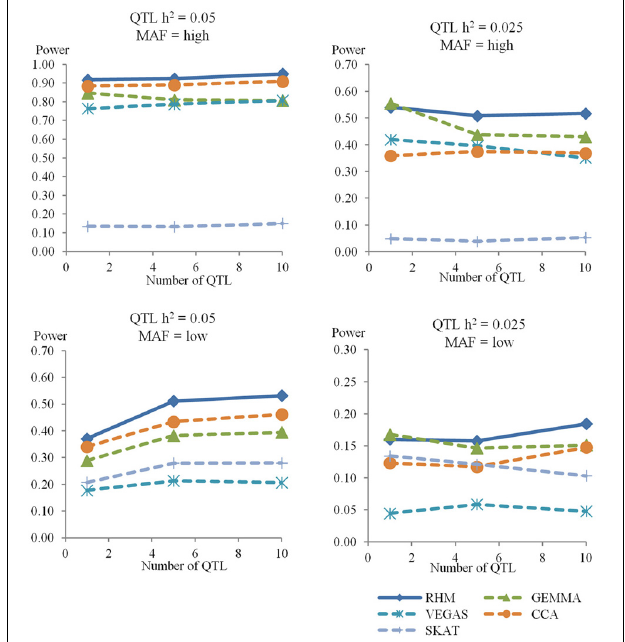
FIGURE 3 | The power to achieve 5% genome-wide significance in the gene region. The powers in the simulation study for genome heritability 0.4 were calculated by RHM with window size 10 (RHM), single-SNP GWAS (GEMMA), and three gene-based association approaches (VEGAS, CCA, and SKAT) in the different situations. The number of QTL is on the x-axis, and the power to detect QTL is on the y-axis. Each graph shows the different situations for genome heritability 0.4 (QTL heritability is 0.05 or 0.025, and MAF is high or